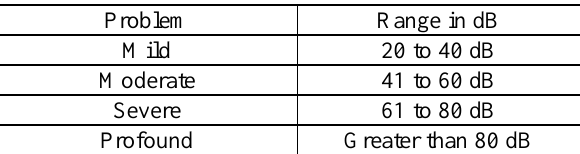
Table 5. Investigation ranges of hearing loss.